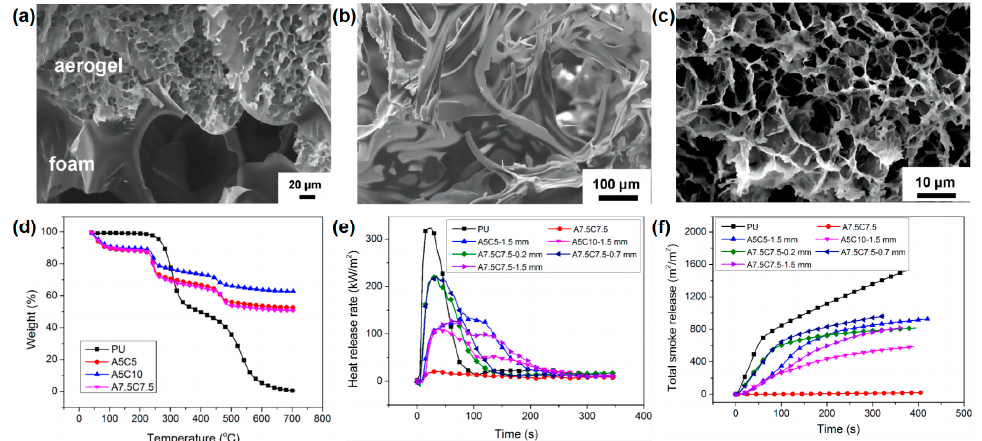
Figure 6. SEM micrograph of ( a ) RPUF/aerogel interface; Char residue of ( b ) RPUF and ( c ) aerogel after LOI test; ( d ) TGA curves of pure RPUF and alginate/clay aerogels with different ratios; ( e ) HRR, and ( f ) TSR curves of samples in cone test [50].